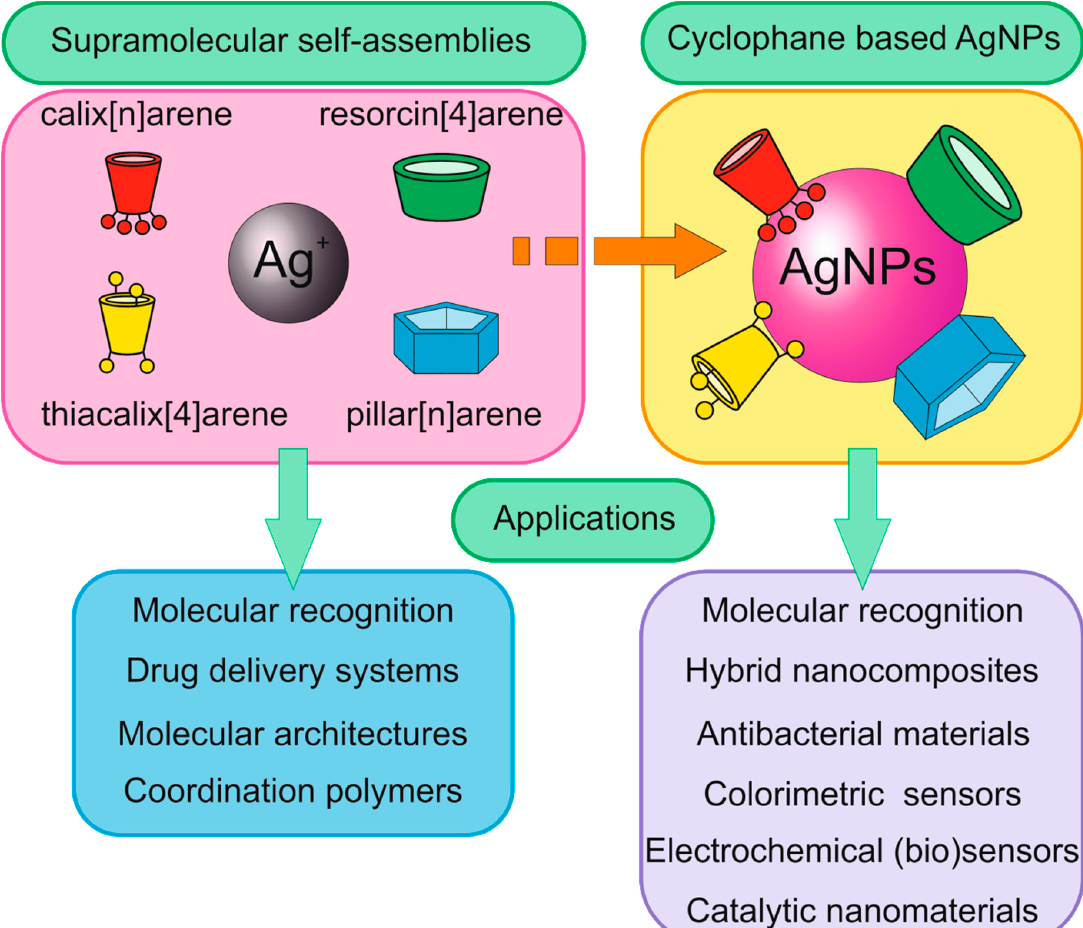
Figure 2. Application of supramolecular self-assemblies “cyclophane-Ag +” and cyclophane based silver nanoparticles (AgNPs).